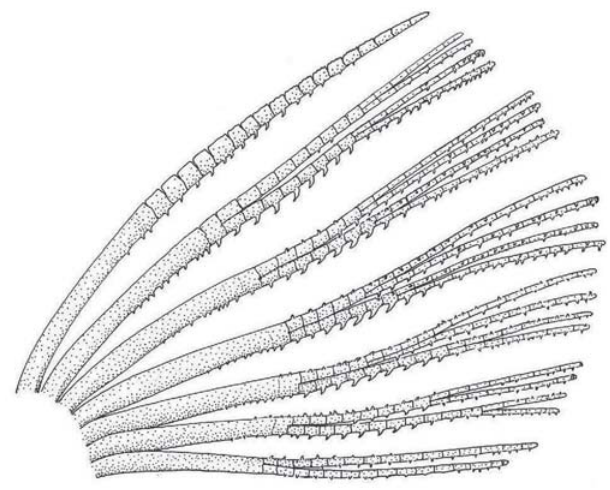
Fig. 17. Glandulocauda melanopleura , adult male, USNM 236415, 42.6 mm SL; pelvic-fin rays, ventral view, left side, anterior at left. First pelvic ray not divided at its distal tip although so divided in some specimens of species.